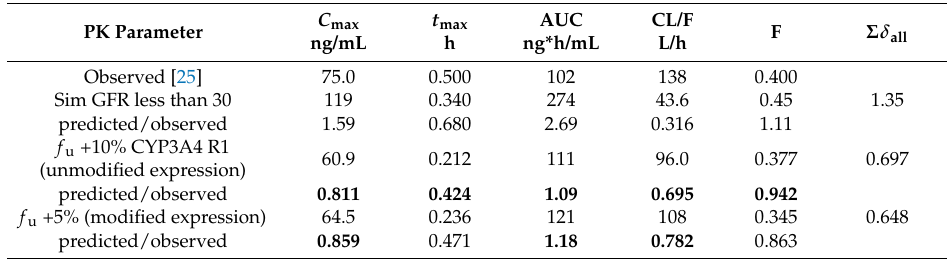
Table 1. Comparison of Predicted and Observed Values for Pharmacokinetic Parameters for Nifedipine in Severely Renally Impaired Patients.